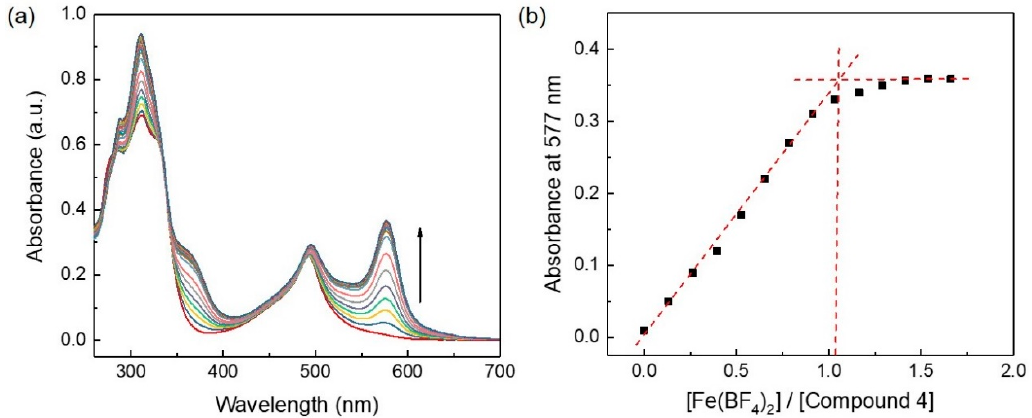
Figure 2. ( a ) Change in the UV–vis absorption of compound 4 (5 × 10 − 6 M in DCM/MeOH 1:1, v / v ) upon gradual addition of Fe(BF 4 ) 2 in MeOH. ( b ) Plot of the absorption of compound 4 at 577 nm as a function of the [Fe(BF 4 ) 2 ]/[compound 4 ] ratio.